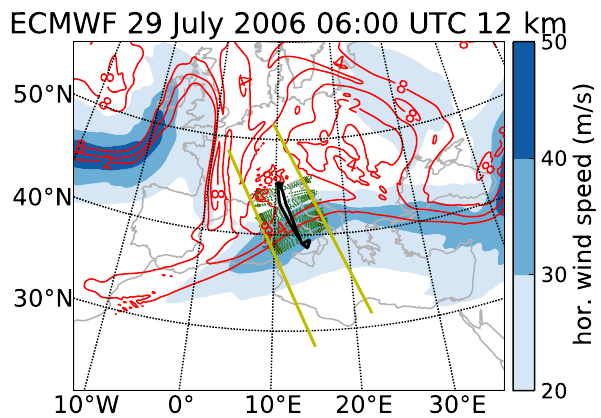
Fig. 2. Overview of aircraft flight path and meteorological situa- tion on 29 July 2006 06:00UTC at 12km altitude. Shown as blue surfaces are horizontal wind speeds. Shown as red contours are po- tential vorticity in PVU. The thick black line shows the flight path of M55-Geophysica. The horizontal position of every fourth tan- gent point of radiance measurements is shown as a small green cir- cle. Yellow dots highlight tangent points closest to 12km altitude. The two yellow lines indicate the horizontal position of two vertical cross sections depicted in Fig.